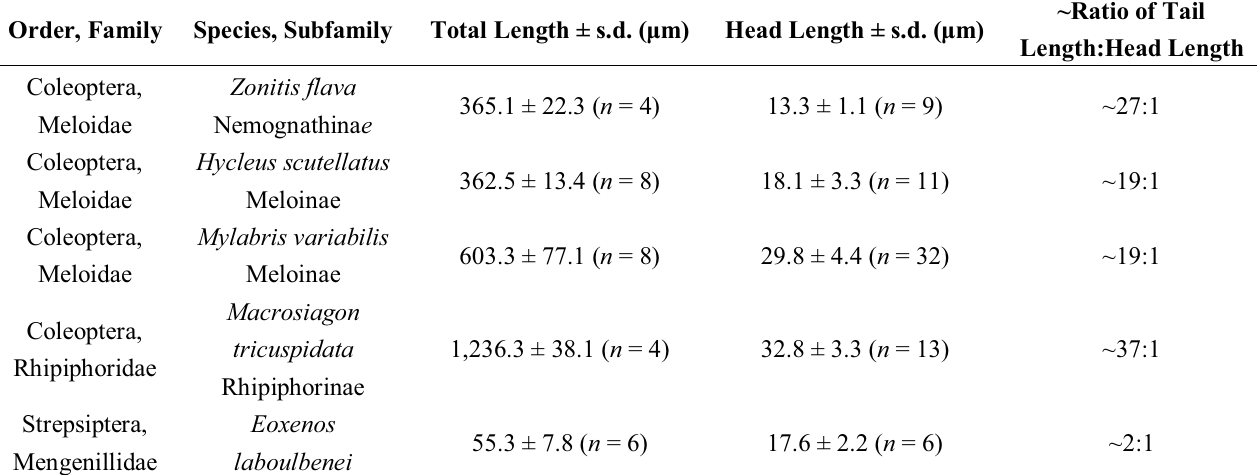
Table 1. Measurements of beetle and strepsipteran sperm